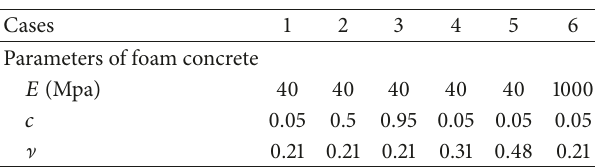
Table 1: Calculation cases.